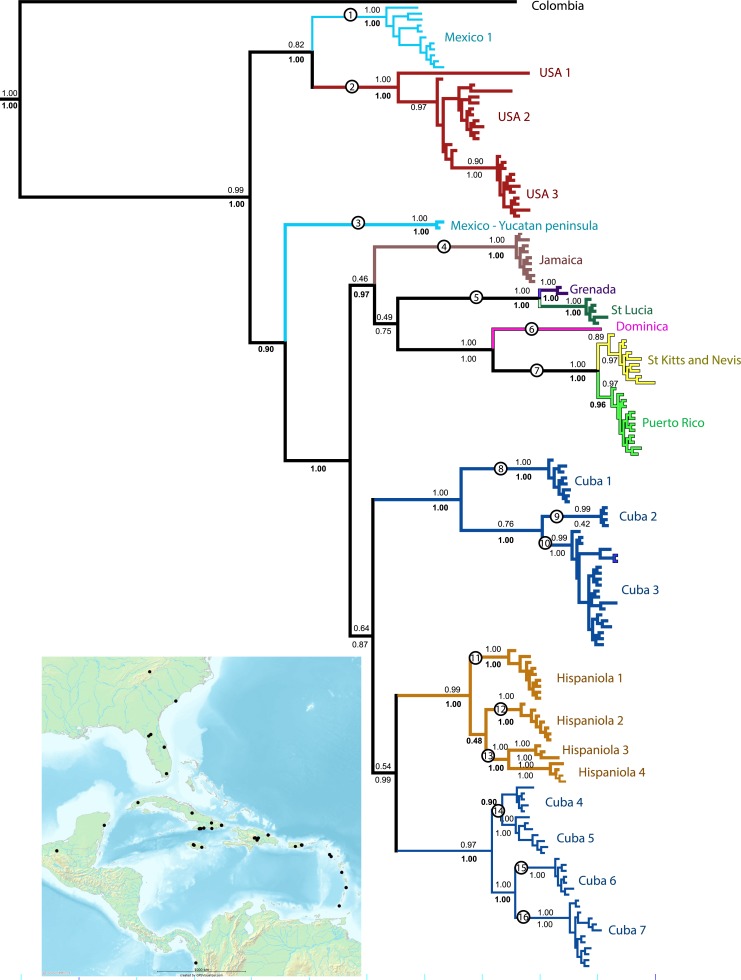
Phylogenetic tree.Results of a Bayesian analysis of the three concatenated loci summarized in terms of region and clade uniqueness. Outgroups are omitted for clarity. Color coded and numbered clades represent our initial species hypotheses based on this tree and barcoding gaps. Encircled numbers on nodes refer to our ‘conservative’ estimtes of actual species richness (see Table 1). Numbers below nodes are posterior probability values, bold indicate clades recovered in the Bayesian analysis of the small nuDNA dataset alone. Results from maximum likelihood analyses of the same dataset are largely congruent, numbers above clades are ML bootstraps. For details of specimens in each clade see Supplemental Information 1 and Table S1. Inset map shows collecting sites for this study.